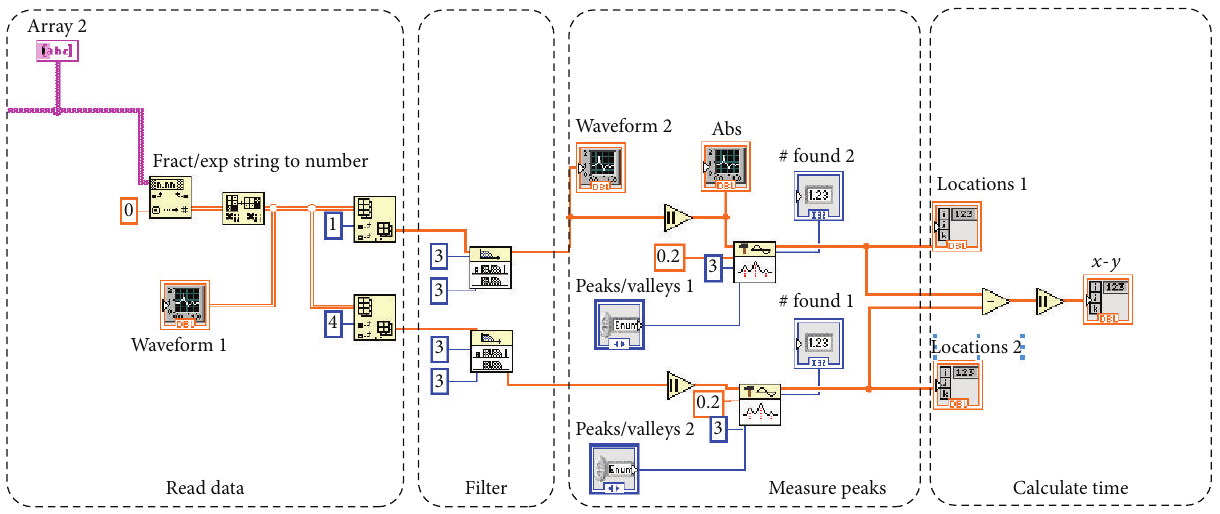
Figure 3: Labview code of peak time interval